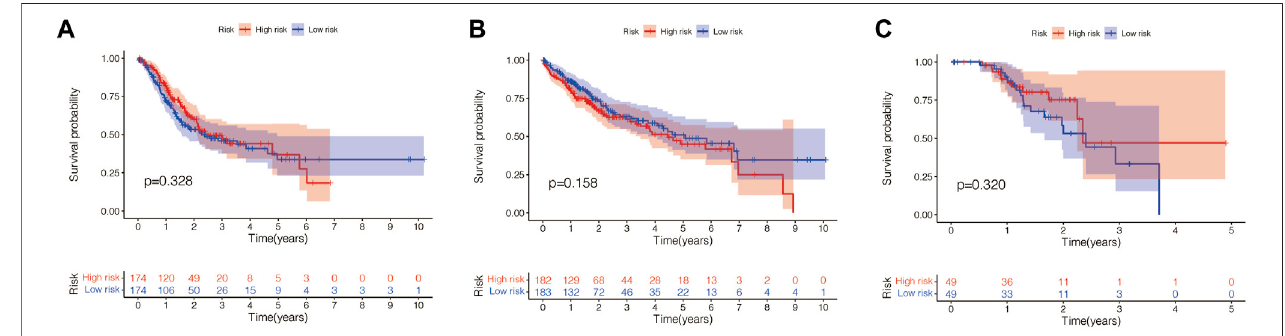
FIGURE12| Theprognosticvalueofthispyroptosis-relatedgenesignatureinothercancers.( A )Thissignaturehasnoprognosticsigni fi canceingastriccancer( p (cid:1) 0.328). ( B ) This signature has no prognostic signi fi cance in liver cancer ( p (cid:1) 0.158). ( C ) This signature has no prognostic signi fi cance in skin melanoma ( p (cid:1) 0.320).